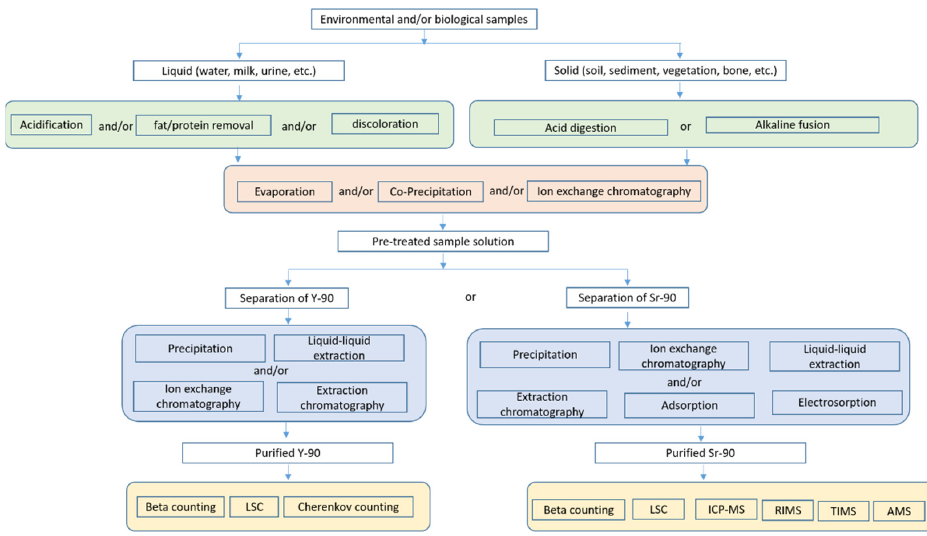
Figure 2. Overview of analytical scheme for 90 Sr in environmental and biological samples.